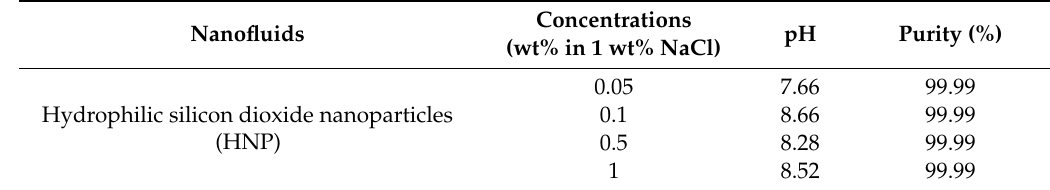
Table 2. Hydrophilic Silicon dioxide Nanoparticle dispersions, concentrations (wt%), pH and purity level.